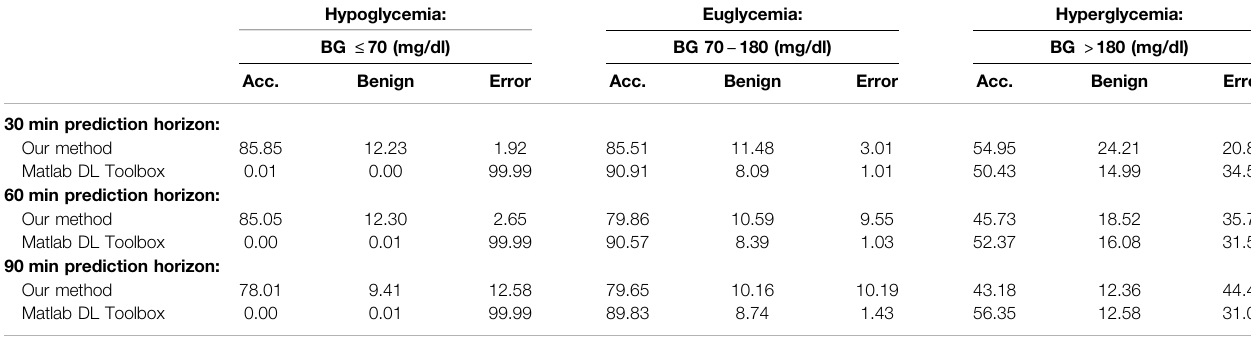
TABLE 7 | Average PRED-EGA scores (in percent) for different prediction horizons on dataset D , with training data selected from dataset J . Hypoglycemia: Euglycemia: